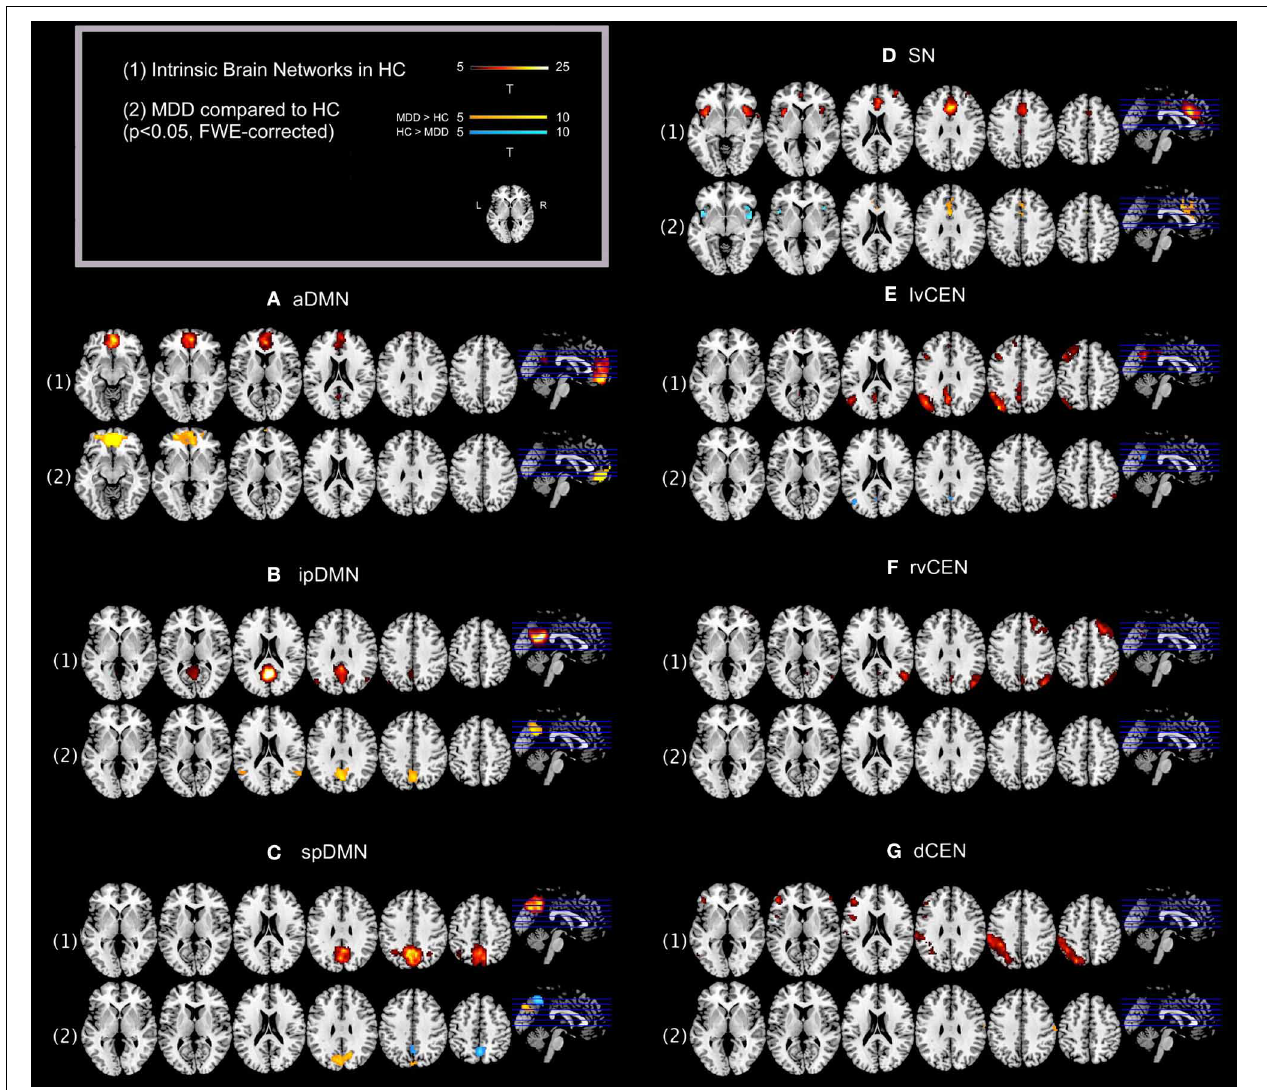
FIGURE 2 | Default mode network, salience network, and central executive network in healthy controls and corresponding group differences for patients with major depressive disorder. (1) Spatial maps of selected ICs (derived from ICA of fMRI data) representing the default mode, salience, and central executive network (DMN, SN, CEN) in healthy controls were entered into voxel-wise one-sample t -tests and thresholded at p < 0 . 05, corrected for family wise error (FWE). Statistical parametric maps (SPMs) representing brain areas with significantly co-varying activity were superimposed on a single-subject high resolution T1 image (color scale representing t -values from 5 to 25; only maps of healthy controls are shown). (2) To analyze between-group differences, patients’ and controls’ ICs of the DMN, SN, and CEN were entered into voxel-wise two-sample- t -test with age, sex, and GM volume of the brain